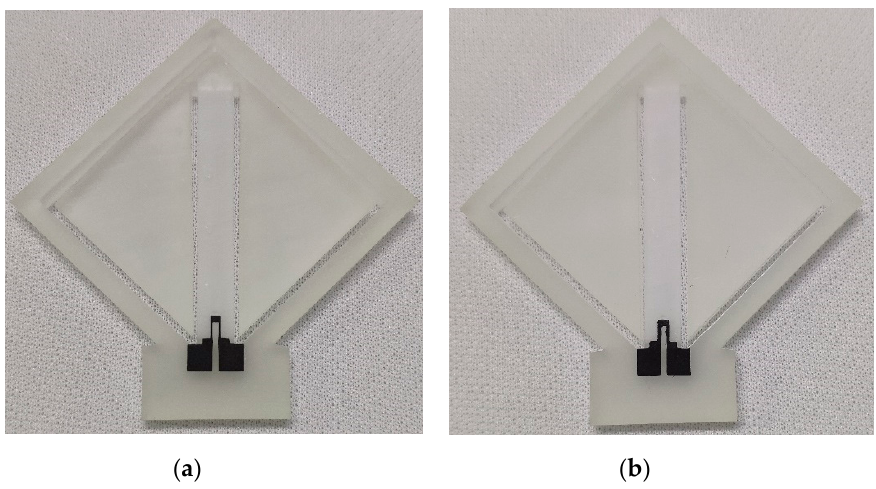
Figure 7. Photographs of ( a ) the accelerometer with the screen-printed strain gauge; and ( b ) the accelerometer with the direct ink writing (DIW) strain gauge.